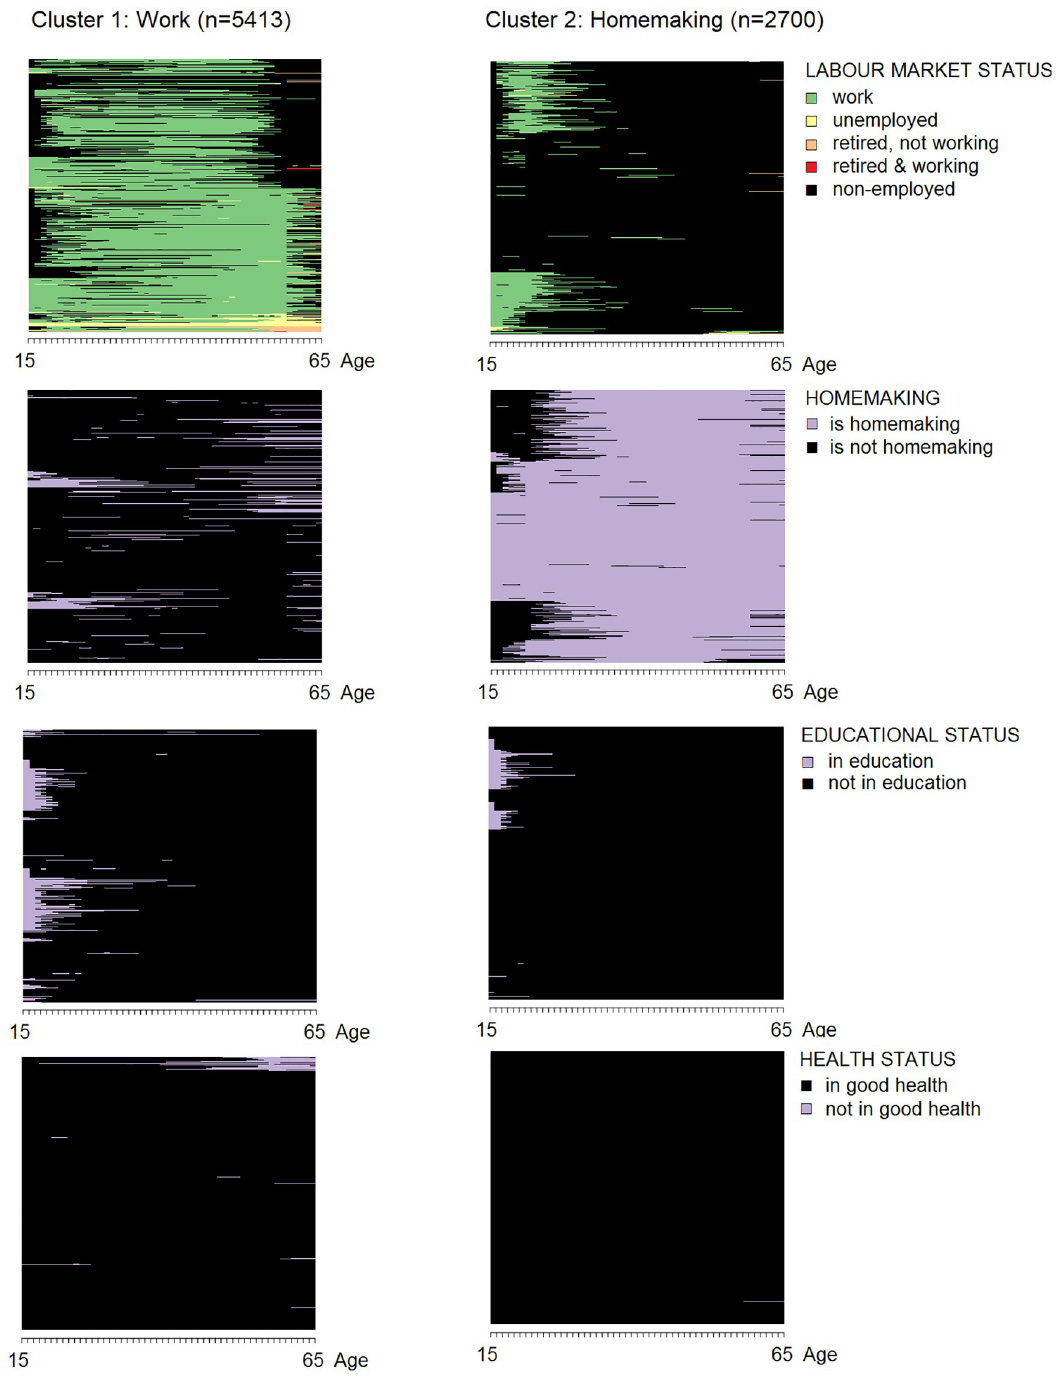
Fig 5. Working age life-course clusters among women.